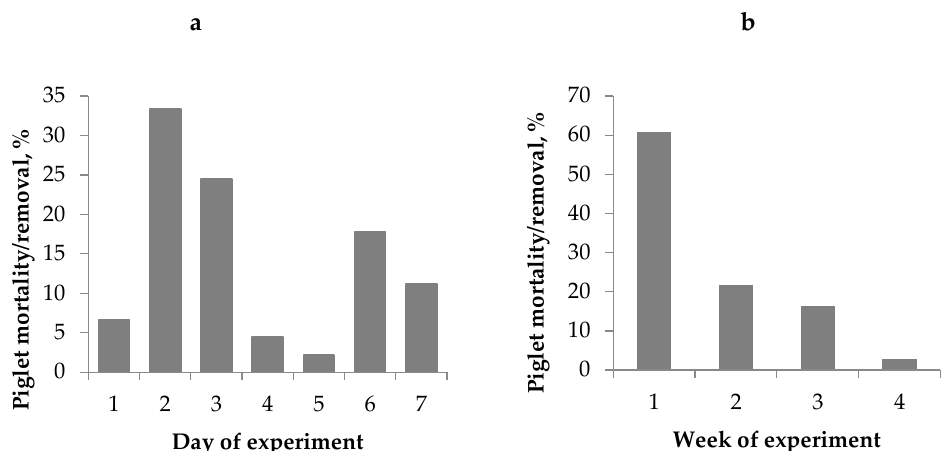
Figure 3. ( a ) Distribution of piglet deaths or being removed in the first week ( n = 45); ( b ) Distribution of piglet deaths or removal over the experimental time period for all piglets ( n = 74).